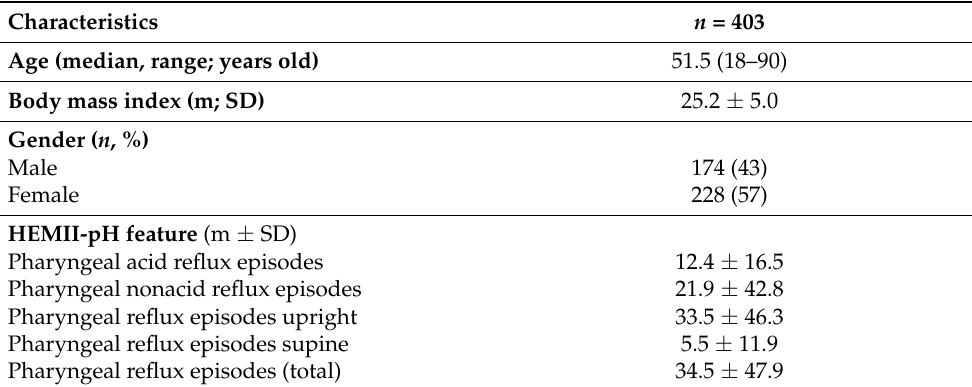
Table 1. Epidemiological and clinical features of